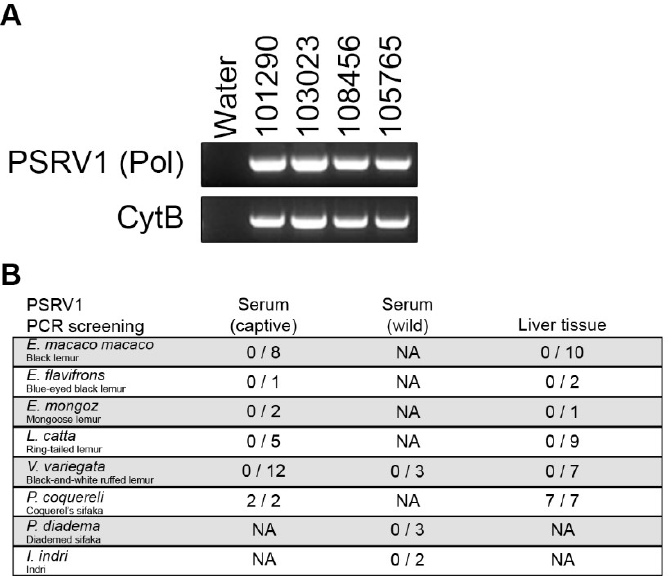
Figure 4. Molecular validation and screening for PSRV1. ( A ) Gel electrophoresis shows PCR am- plification of PSRV1 ( pol gene) and host cytochrome B gene ( cytB ) of nucleic acid extracted from 4 Coquerel’s sifaka liver tissues (IDs: 101290, 103023, 108456 and 105765) and a water negative control. ( B ) Screening results of a diverse panel of lemur species. Only P. coquereli tested positive for PSRV1 in both sera and liver tissue.